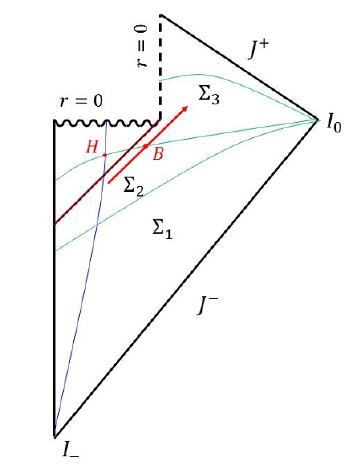
Figure 2 . Penrose diagram for evaporating black hole. On the time slice (cid:6) 2 the information about collapsing matter H is also present in Hawking radiation B